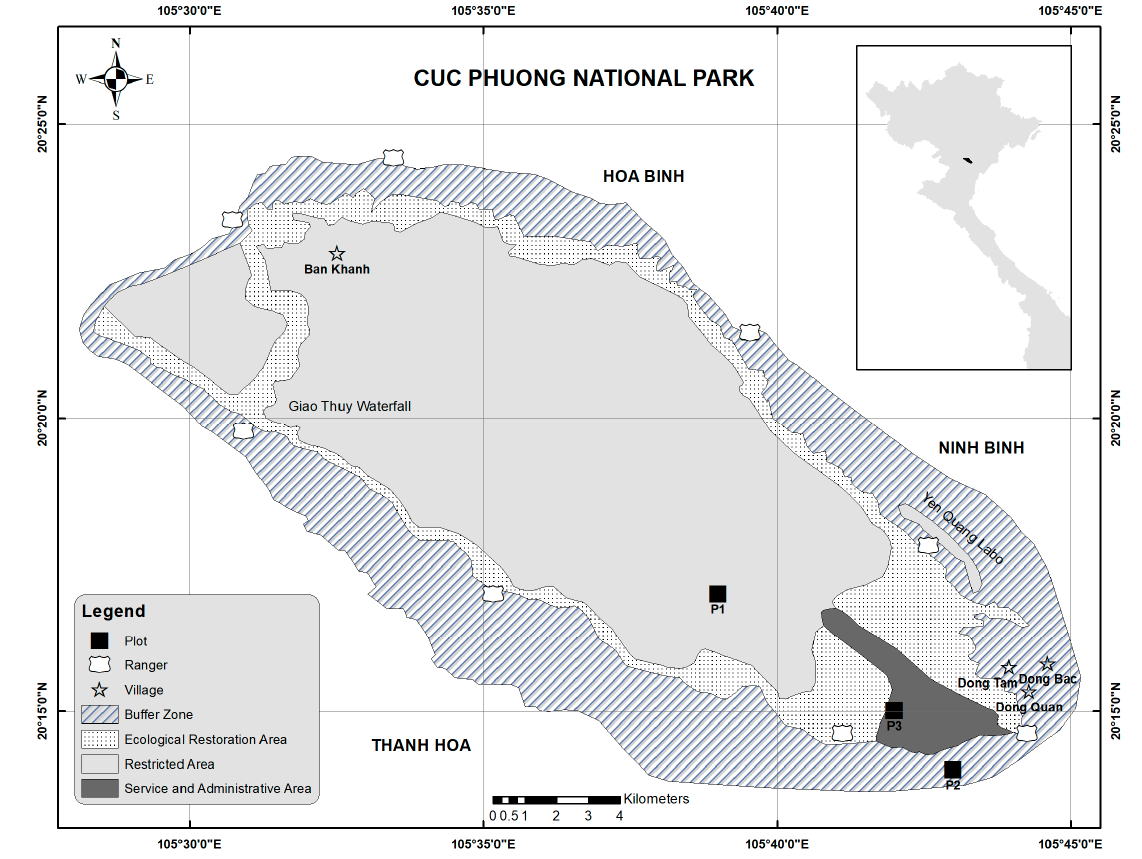
Figure 1. Map of Cuc Phuong National Park and three study plots P1–P3.